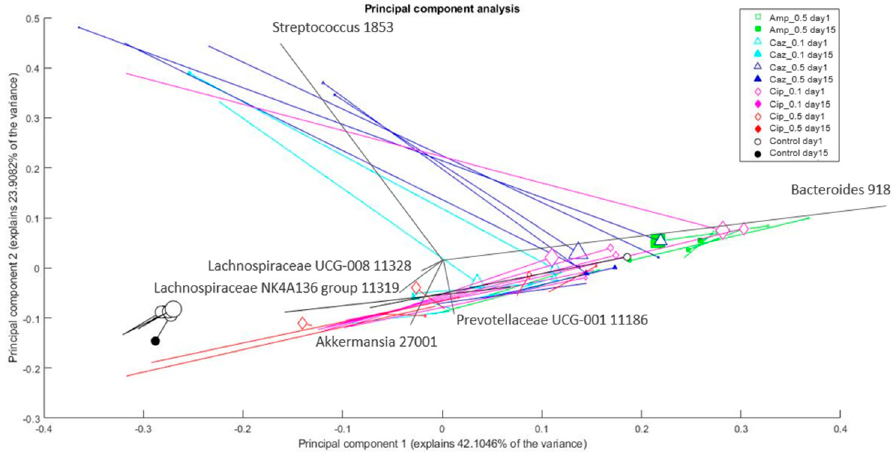
Figure 6. Changes in the composition of bacterial genera in the microbiota after different treatments. The % of variance explained by the component is shown on the axes; each marker represents one sample; colors correspond to the treatment (drug + dose) (Amp_0.5: green; Caz_0.1: cyan; Caz_0.5: blue; Cip_0.1: magenta; Cip_0.5: red; control: black); marker shapes correspond to the treatment (drug) administered. Legend: square: Amp; triangle: Caz; rhombus: Cip; circle: control; marker area refers to the sampling date (empty marker: day 1; full marker: day 15); lines connect the samples from the same source; therefore, changes in a sample (in the principal component analysis (PCA) space) can be seen from the empty marker to the full one following the line between them. Marker size correlates with Klebsiella content (relative abundance) of the sample. Arrows show the direction and importance of the original dimensions (the taxonomic categories) in the PCA space. PCA plot with uniform marker size (without Klebsiella ) may be found in Supplementary Figure S4 in the Supplementary material S1.